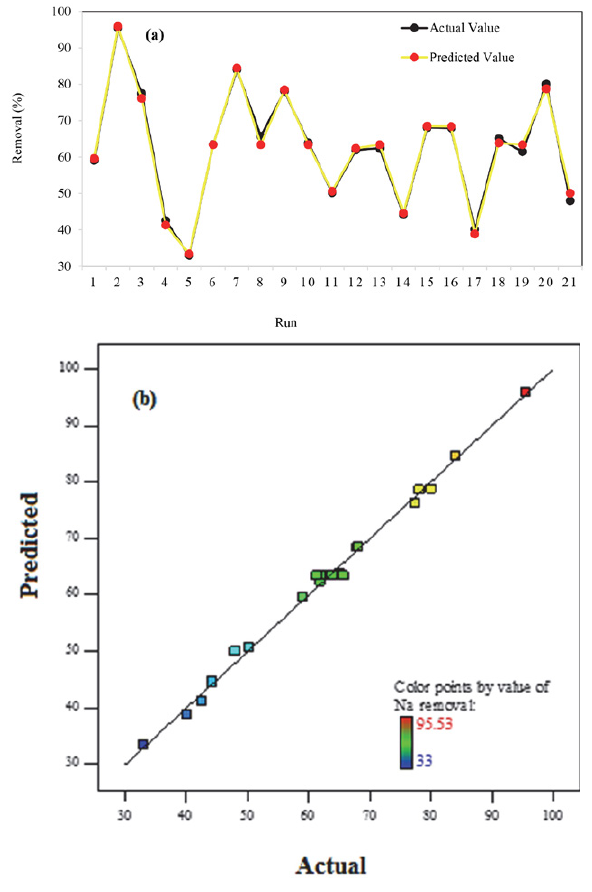
Figure 8. Predicted and real values of efficiency in different runs of the experiment (a) the experimental results versus the predicted re- sults by the software